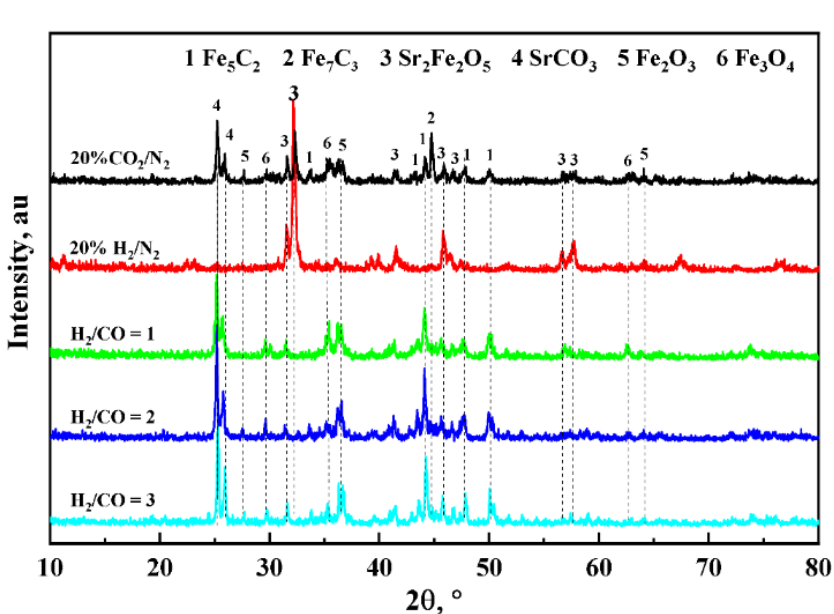
Figure 12. XRD patterns for SKF0.4 catalysts after reduction under different conditions (350 °C, 1.0